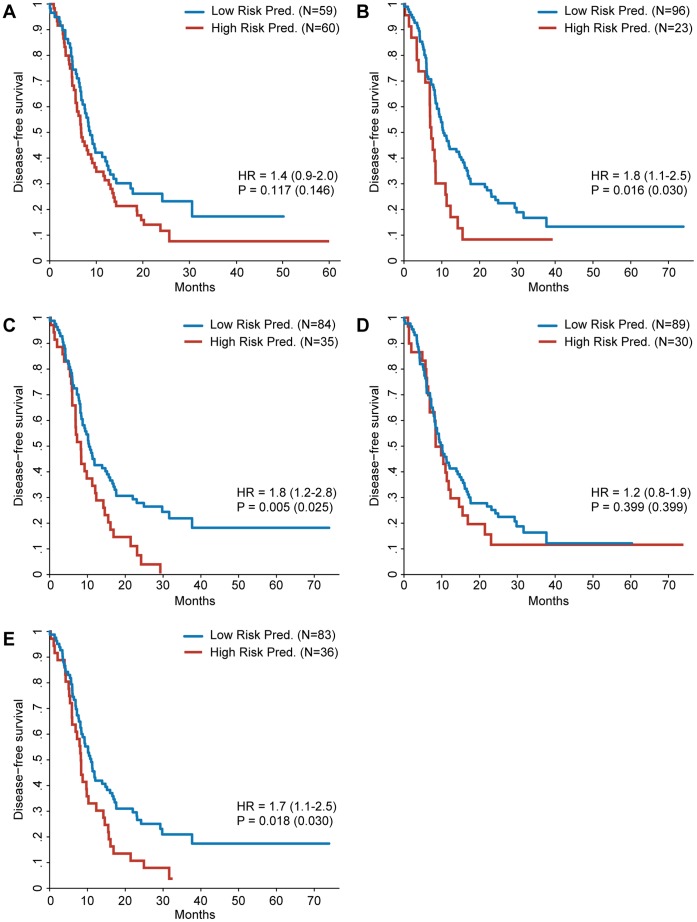
Kaplan–Meier survival analysis for clinical risk predictors.Survival curves based on all 119 patients using known clinical predictors. The hazard ratio of the clinical risk predictor is shown with the 95% confidence interval between brackets. The p value of the log-rank test is shown as well, with the p value adjusted for multiple testing between brackets. A: Iwatsuki (high risk ≥3, low risk <3). B: Basingstoke (high risk ≥10, low risk <10). C: Fong (high risk ≥3, low risk <3). D: Mayo (high risk ≥2 low risk <2). E: Nordlinger (high risk ≥4, low risk <4).